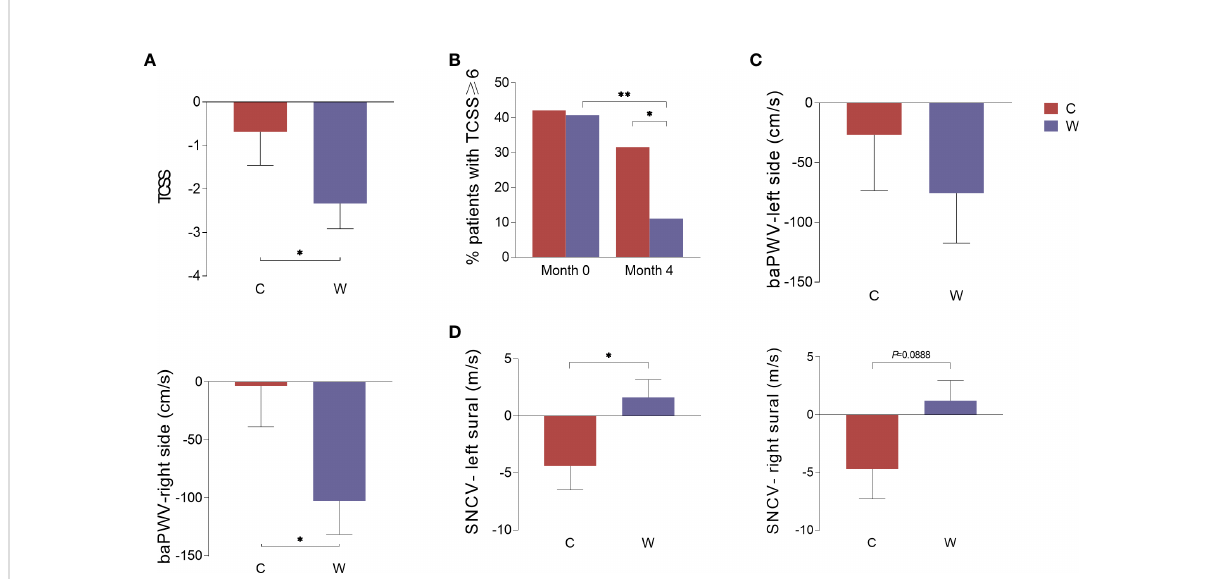
FIGURE 2 The change in indices representing diabetic complications during the intervention. Data were calculated according to the change in indices in Group C and Group W before and after the 4-month intervention. TCSS (A) , the percentage of patients with TCSS ≥ 6 (B) , the baPWV on the left and right sides of the body (C) , and the conduction velocity of the left and right sural sensory nerves (D) . * P <0.05; ** P